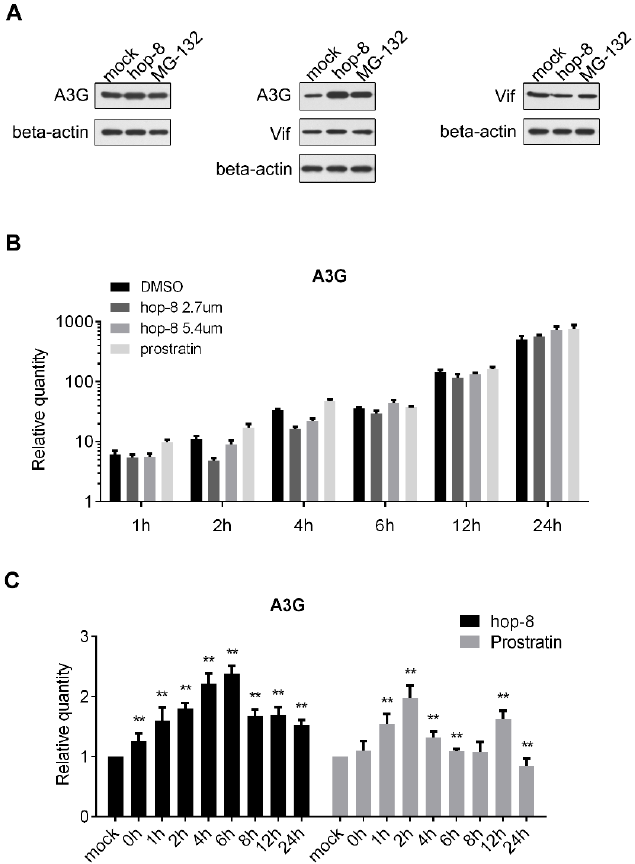
Figure 5. Hop-8 upregulated both the protein and mRNA levels of A3G. ( A ) Hop-8 upregulated A3G protein level regardless of whether Vif was present or absent and had no influence on Vif expression. pcDNA3.1-APOBEC3G-HA and pcDNA3.1-Vif-HA were transfected consecutively or co-transfected into 293T cells and cultured with DMSO, 2.7 μ M hop-8, or 10 μ M of the proteasome inhibitor MG-132 for 24 h. A3G, Vif, and beta-actin were detected by western blot; ( B ) A3G mRNA levels of pcDNA3.1-APOBEC3G-HA transfected 293T cells in the presence of the 2.7 µ M (dark gray) and 5.4 µ M (gray) hop-8, prostratin (2.7 µ M) (light gray), or DMSO (black). The cells collected at 4 h post transfection (0 h of compounds treatment) were used as a control. Each data point